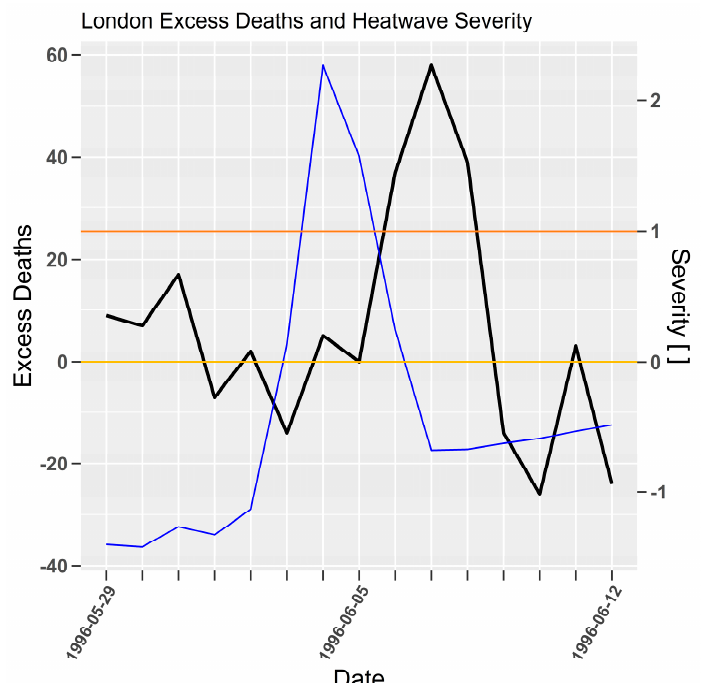
Figure 5. As per Figure 4. London (Heathrow) severity (blue) and mortality (black) for 1996 heatwave. Daily excess deaths and severity (dimensionless) on left and right y -axes respectively.